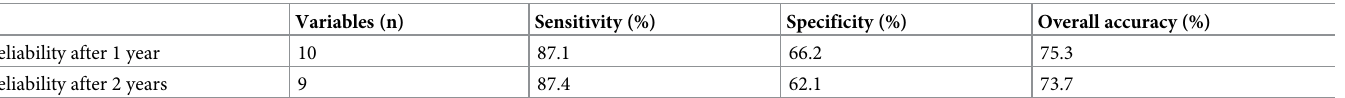
Table 4. The number of variables, sensitivity, specificity and overall accuracy of both models that predict reliability of the erection at 1 year and 2 years post- diagnosis.